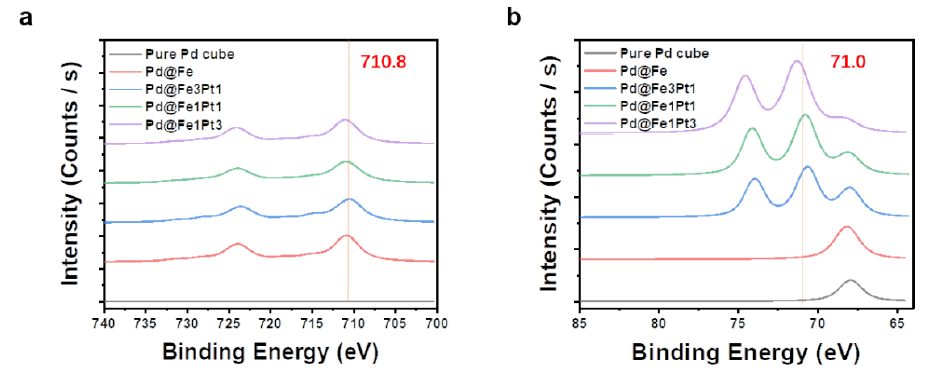
Figure 3. X-ray photoelectron spectroscopy (XPS) of ( a ) Fe 2p and ( b ) Pt 4f spectra of Pd, Pd@Fe, and Pd@FePt nanoparticles.